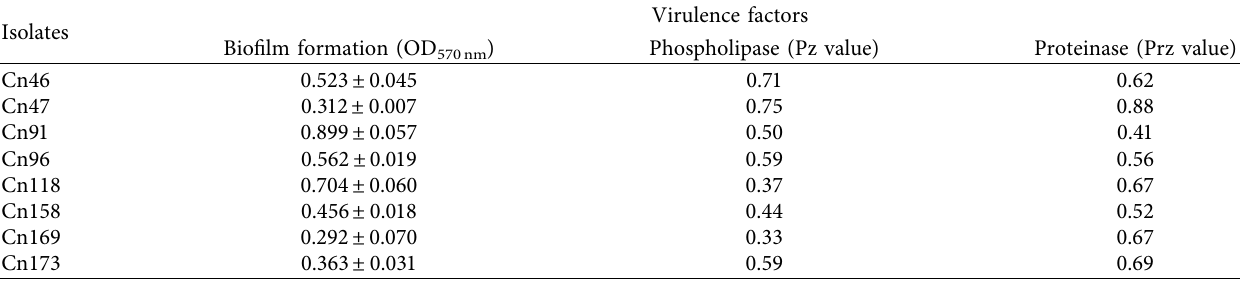
Table 1: Virulence factors in C. neoformans isolates.